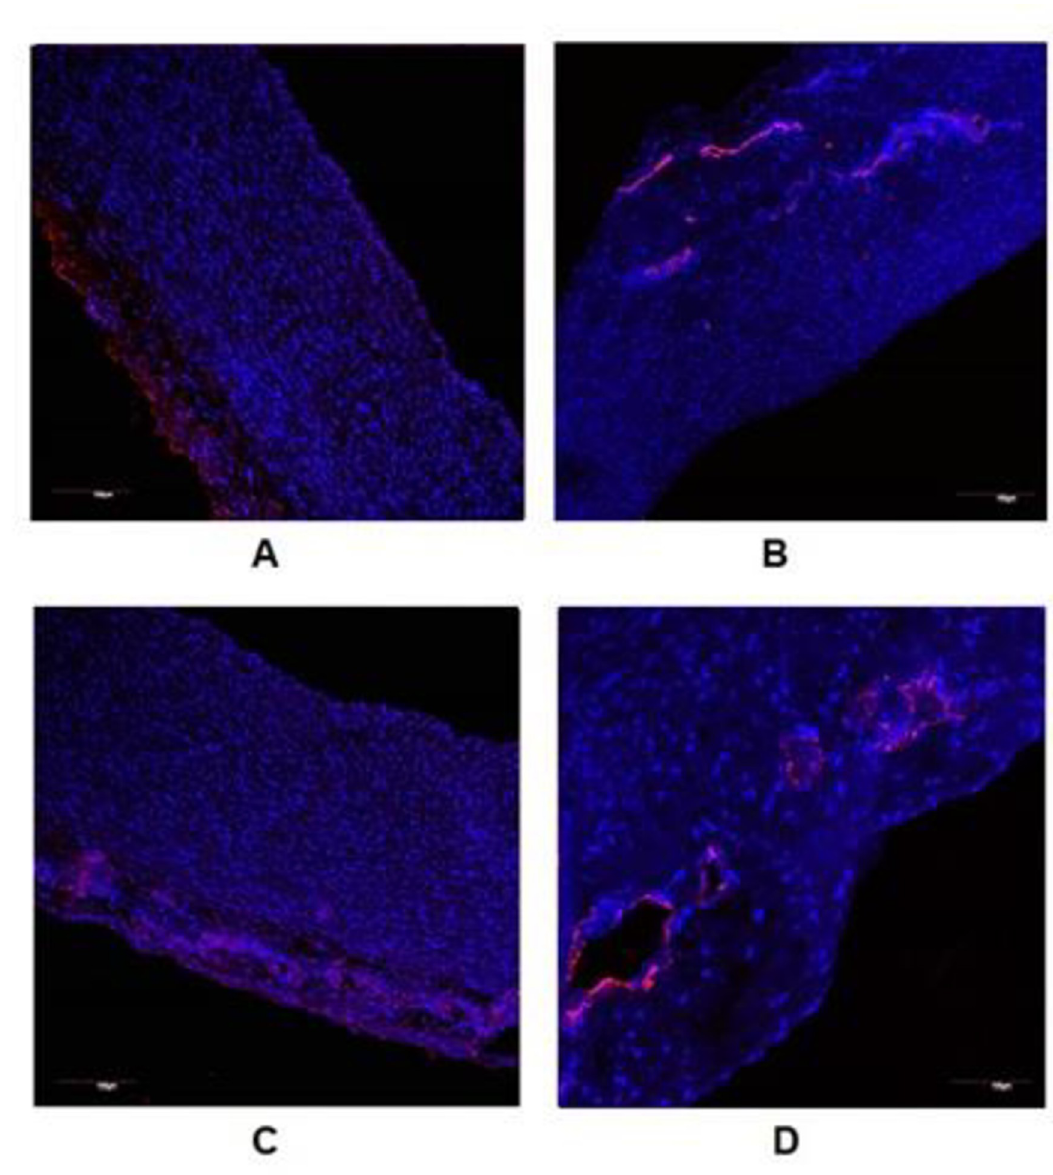
Fig 7. Expression of receptors to melatonin 1 (RMt1) and 2 (RMt2) in the aorta. Immunofluorescent staining with antibodies to melatonin 1 and 2 receptors (red fluorescence), Hoechst nuclear stain (blue fluorescence), х 400. A—infants with SIDS, RMt1, B— the control group RMt1, C—infants with SIDS, RMt2, D—the control group